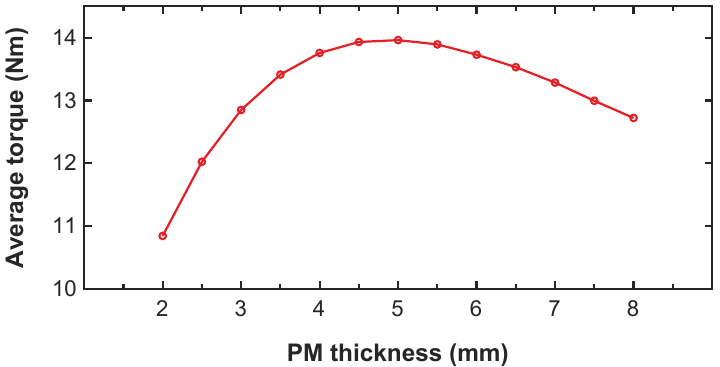
Figure 12. Relationship between PM thickness and average